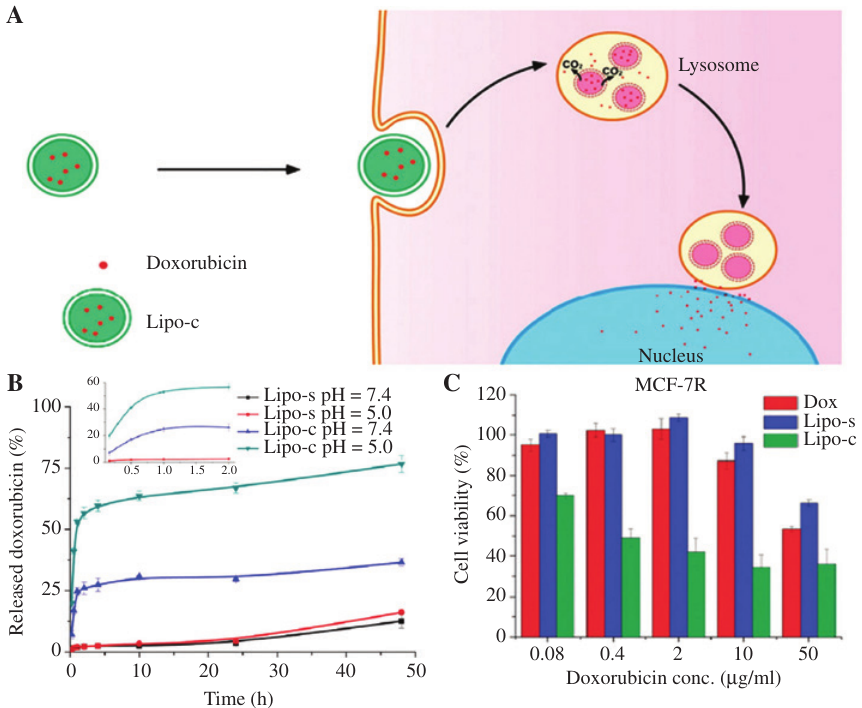
HCO will produce CO in an acidic 4 3 2